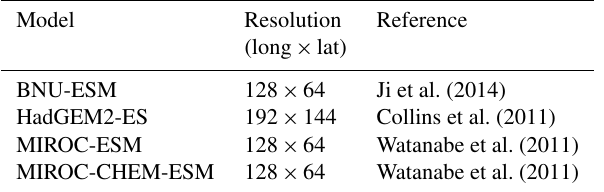
Table 2. ESMs used in this